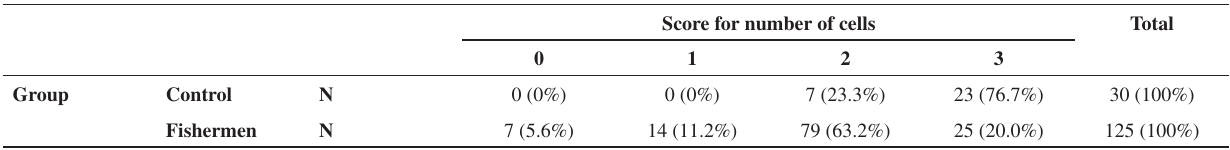
Table 2 - Comparison of cell number in the smears in the control and fishermen groups.